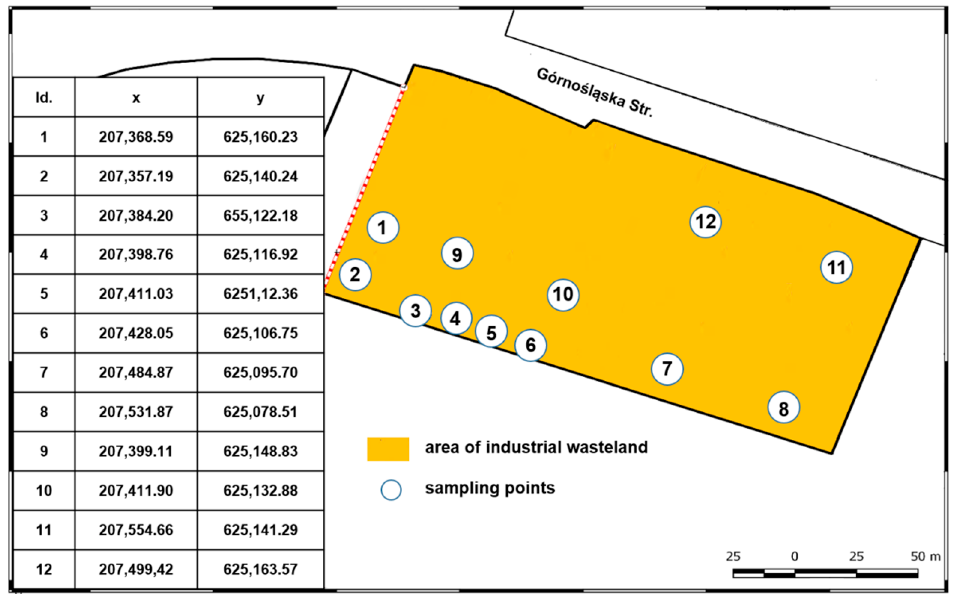
Figure 1. Location of sampling points on an industrial wasteland with historically coal-tar-contaminated soil.